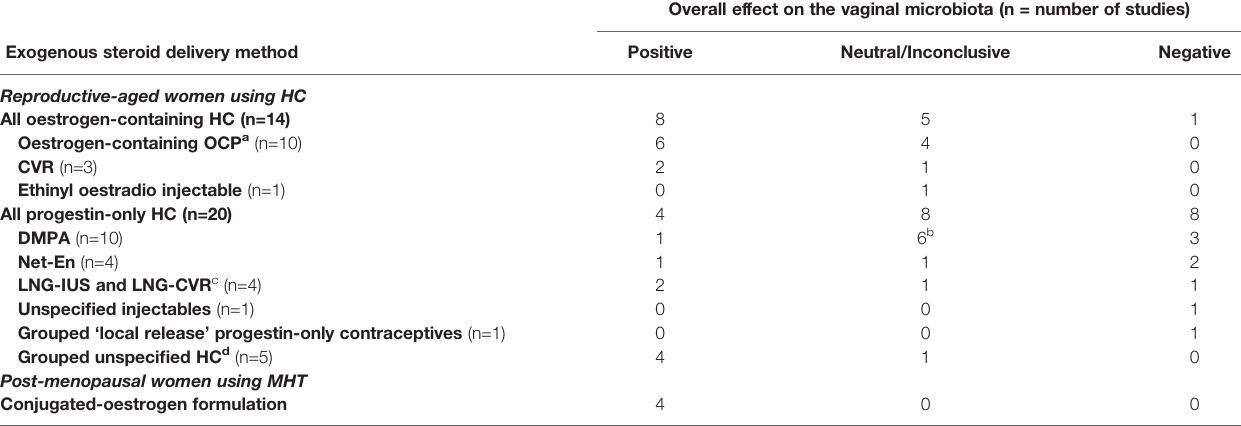
TABLE 3 | Summary of bene fi cial, neutral/inconclusive and detrimental effects of exogenous sex steroids on the vaginal microbiota. Overall effect on the vaginal microbiota (n = number of